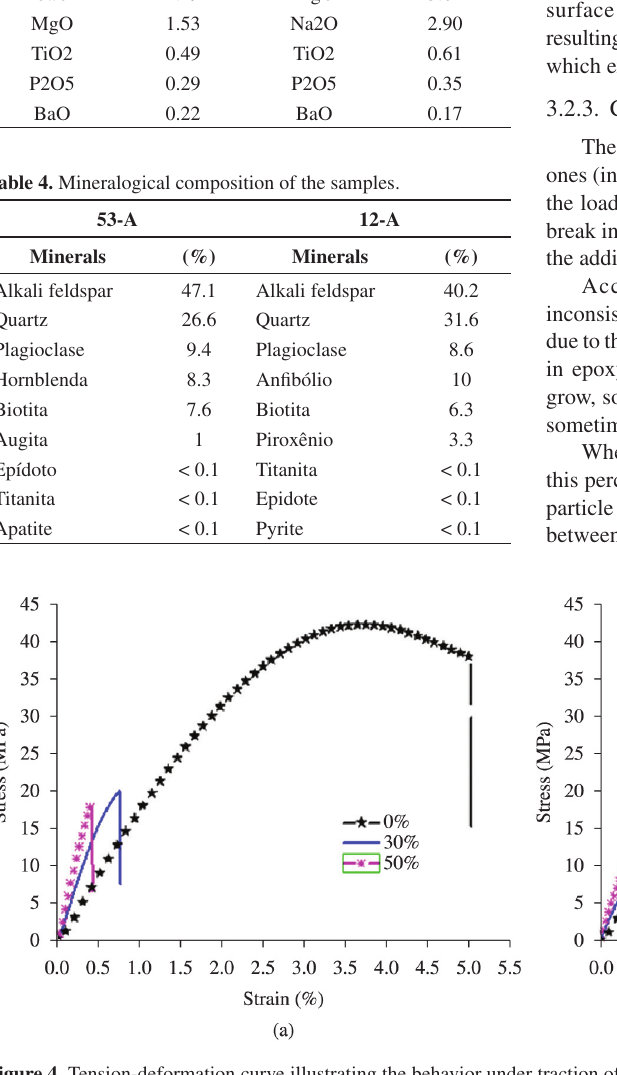
Figure 4. Tension-deformation curve illustrating the behavior under traction of polymeric systems for: a) epoxy resin and 53-A, and b) epoxy resin and